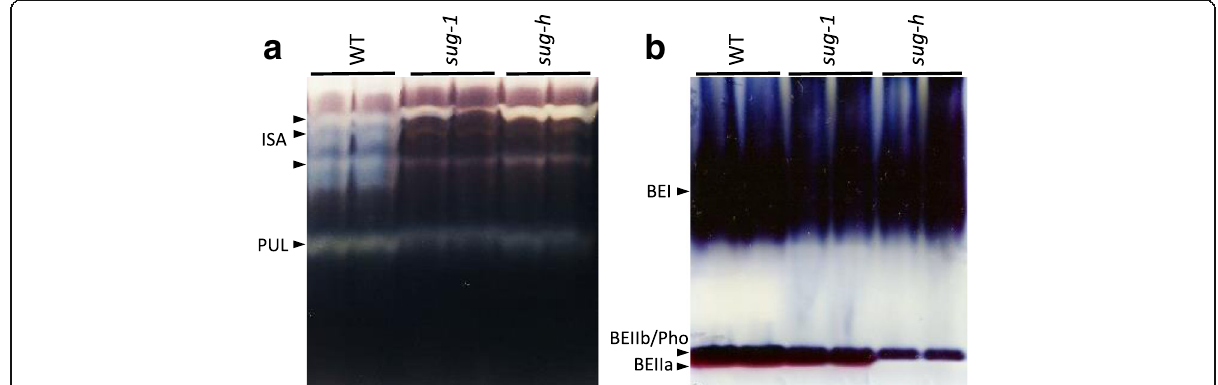
Fig. 7 Native-PAGE/activity staining of developing endosperm in wild-type and mutant seeds. a Native-PAGE/debranching enzyme (DBE) activity staining of rice endosperm at late-milky stage. The ISA and PUL activity bands are indicated by black arrows. b Native-PAGE/branching enzyme (BE) activity staining. The BEI, BEIIa and BEIIb/Pho activity bands are indicated by black